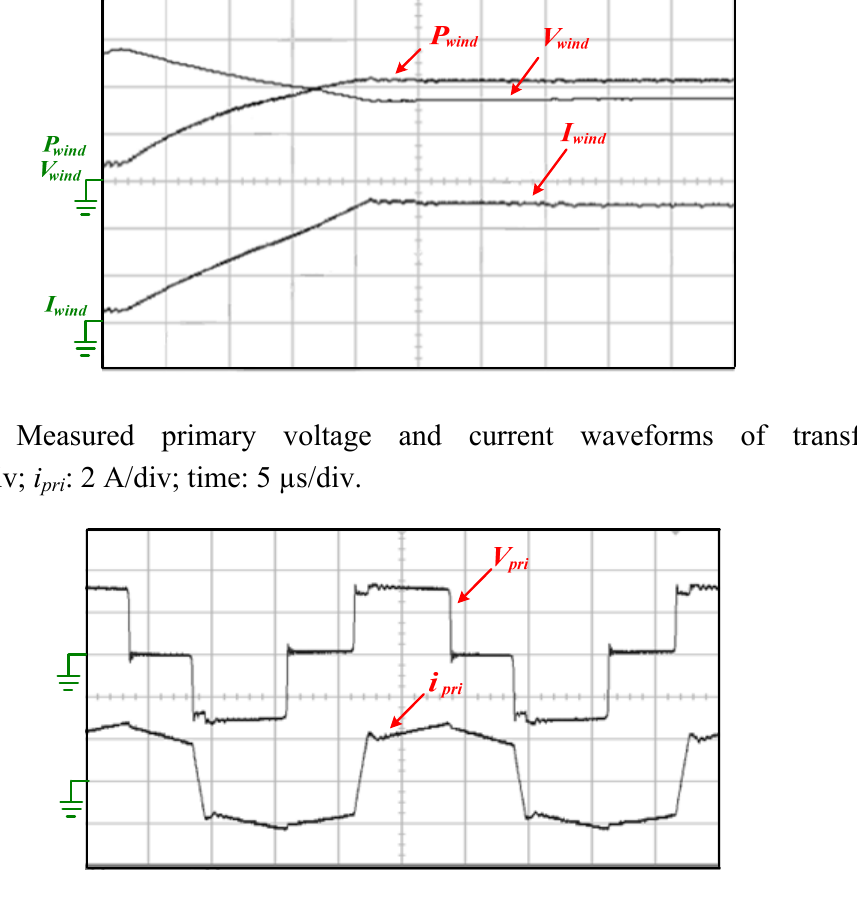
and L ) for current-doubler 1 2